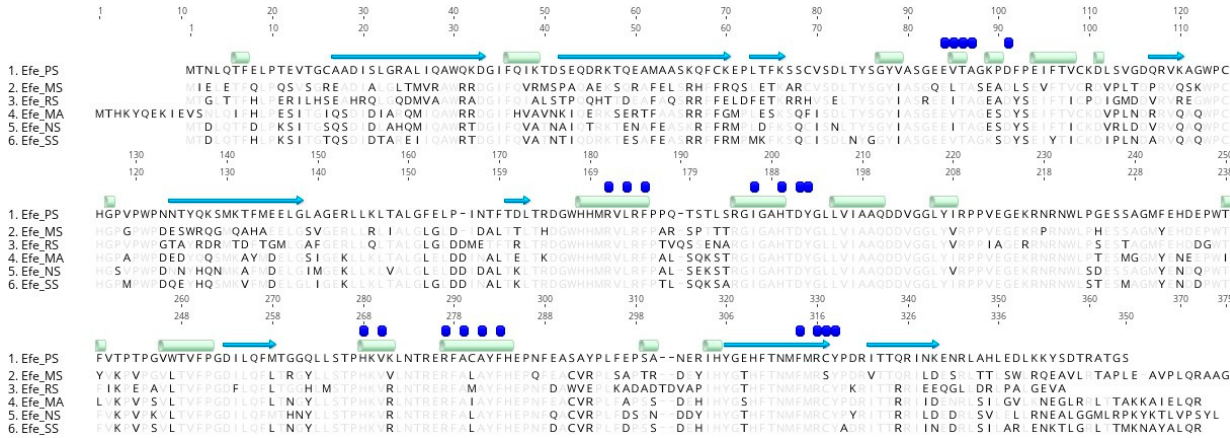
Figure 3. Amino acid sequence alignment ( α -helix: green box, β -strand: blue arrow, activity sites: blue box) between five proteins and AAD16440.1 (Efe_PS).